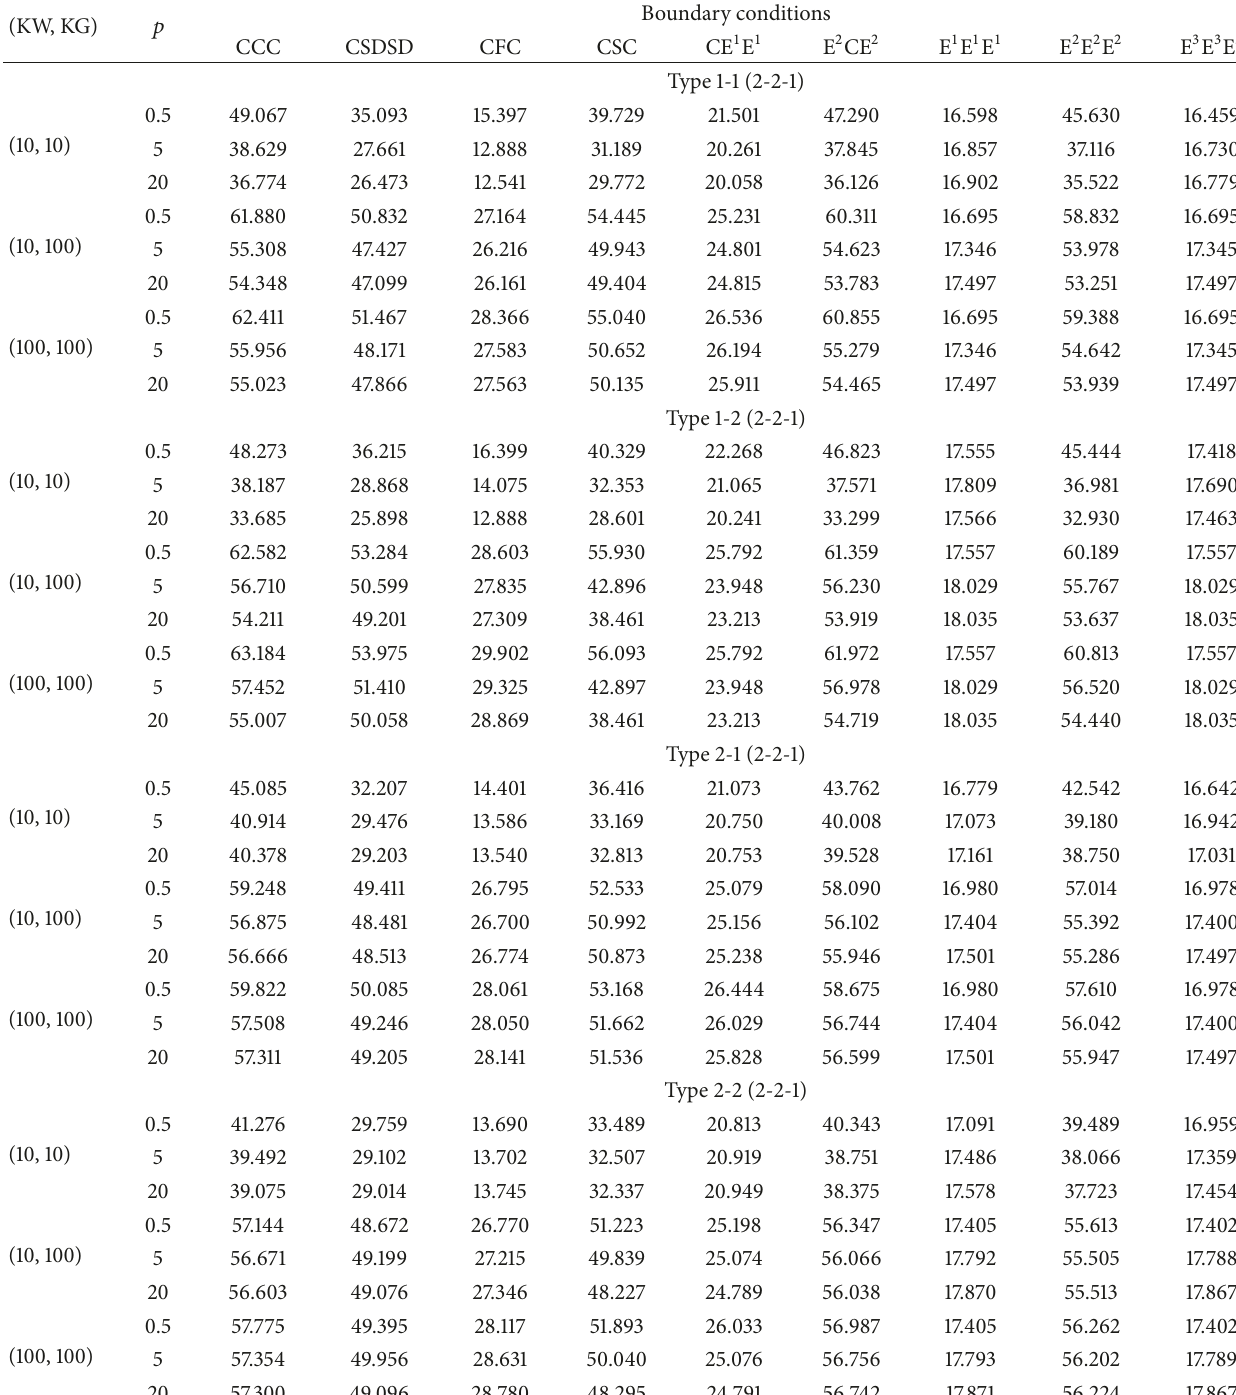
Table 15: Fundamental frequency parameter Ω for circular sector plate with various boundary conditions and material types ( 𝜙 = 120 ∘ , ℎ/𝑅 1 = 0.2, and 𝑝 1 = 𝑝 2 = 𝑝 3 = 𝑝